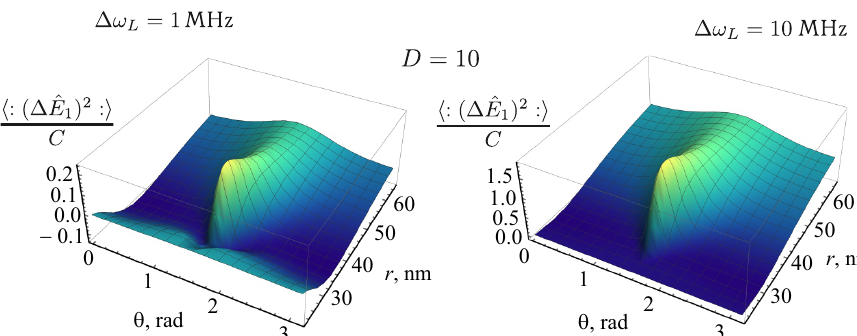
Figure 14. Dependences of quantity (cid:104) : ( ∆ ˆ E 1 ) 2 : (cid:105) normalized to C on the position of a QE at D = 10 and different values of ∆ ω L : ∆ ω L = 1 MHz ( left ) and ∆ ω L = 10 ( right ) in the presence of a nanosphere.